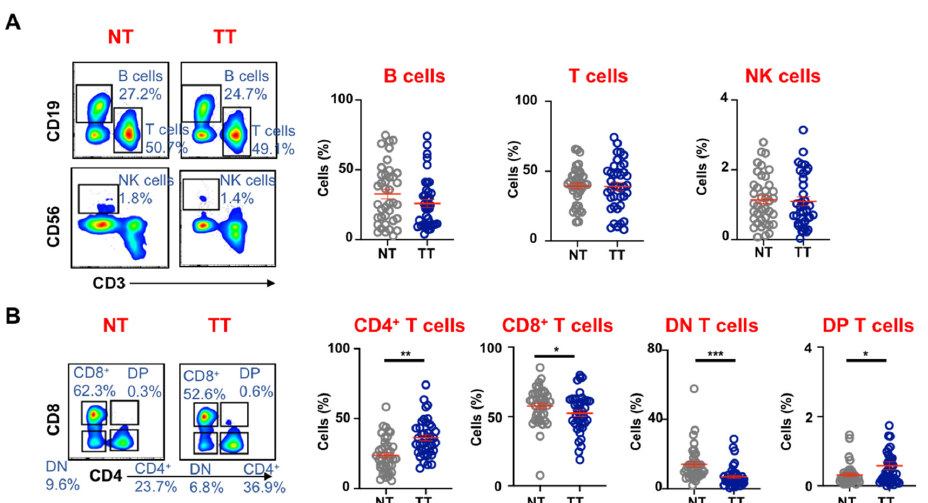
Figure 1. Lymphocyte populations in the colorectal tumor microenvironment. Levels of lymphoid cells were measured in the tumor microenvironment of colorectal cancer (CRC) patients, compared with their levels in normal tissues. Cells were isolated from tumor tissues (TT) and normal tissues (NT) of 50 CRC patients for flow cytometric analyses. Representative flow cytometric plots and cumulative scatter plots show levels of CD19 + B cells, CD3 + T cells and CD56 + NK cells in NT and TT ( A ). Representative flow cytometric plots and cumulative scatter plots show levels of different CD3 + T cell subsets; CD4 + , CD8 + , CD4 − CD8 − (DN), and CD4 + CD8 + (DP) T cells in NT and TT ( B ). The p values are represented as follows; * p < 0.05, ** p < 0.01, *** p < 0.001.